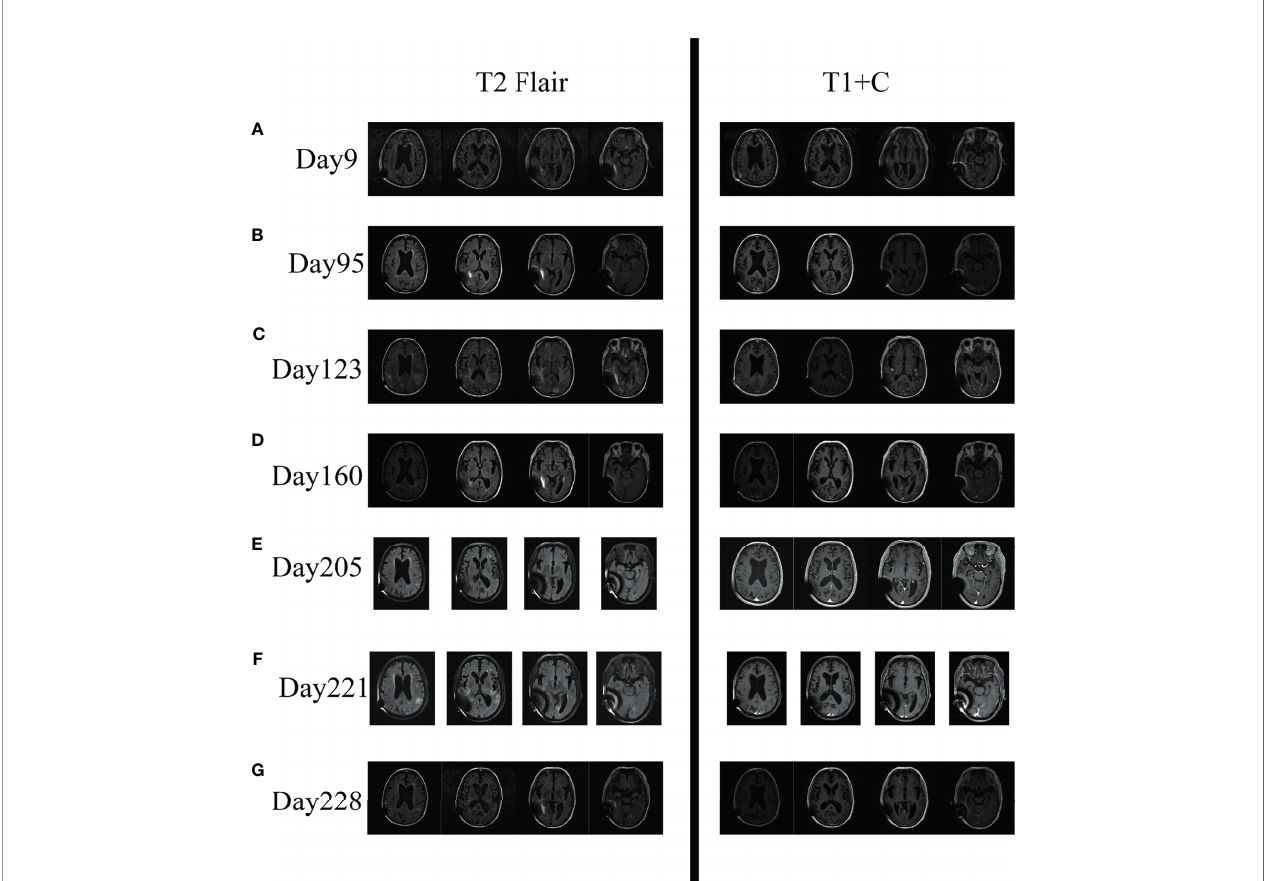
FIGURE 2 | Serial axial brain MR imaging of the patient. (A, B) Imaging on Day 9 and Day 95 showed enlarged ventricles and widened brain fi ssure; T1+C showed no abnormal enhancement. (C) Imaging on Day 123 showed new lesions in bilateral occipital lobe, insular lobe, hippocampus, and paraventricular (T2 Flair); T1+C showed meningeal enhancement and ependymitis/choroiditis after effective antifungal therapy. (D, E) Imaging on Day 160 and Day 205 showed marked improvement of the lesions on day 123 after corticosteroid treatment. (F) Imaging on Day 221 showed that the lesions reappeared after discontinuing corticosteroid. (G) Imaging on Day 228 showed that the lesions decreased after reusing